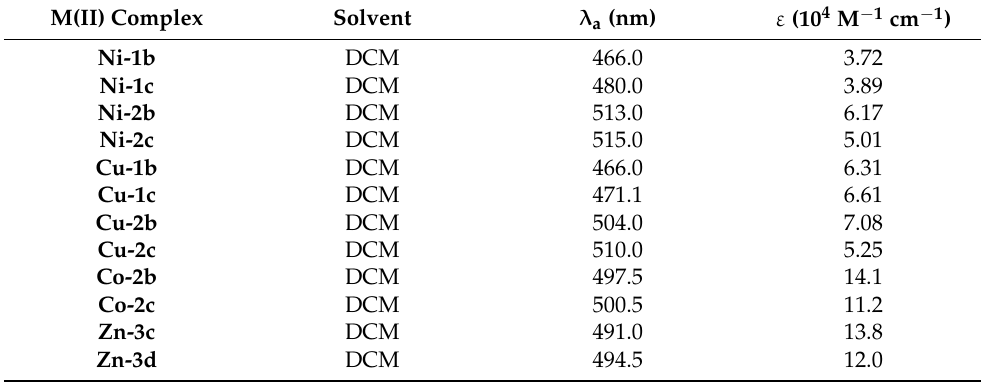
Table A4. Photophysical properties of several (dipyrrinato)Ni(II), -Cu(II), -Co(II) and -Zn(II) com- plexes in DCM at room temperature